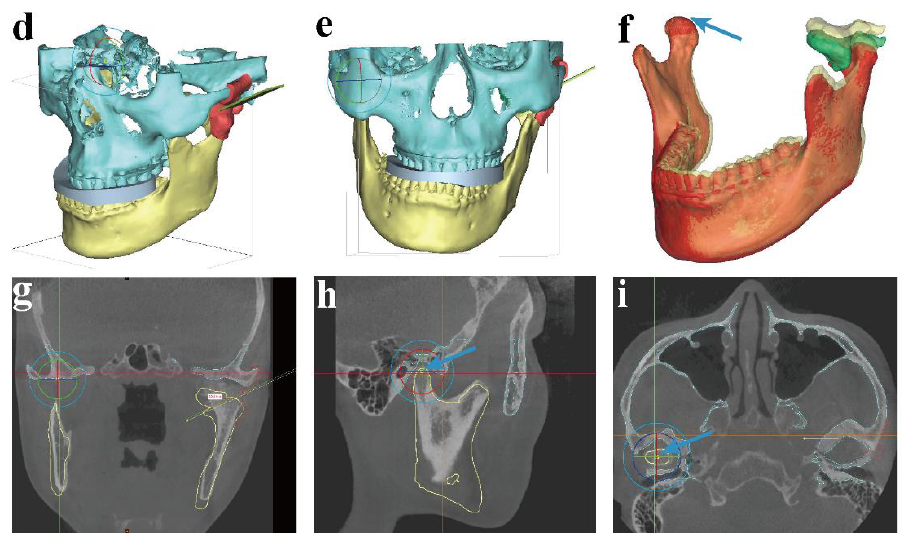
Figure 3. The process of virtual planning and 3D-printed template design. ( a ) The original maxilla, mandible, and condylar OC; ( b , c ) designed DOS, DOT, and adjust direction of the osteotomy plane in the position of the rotated mandible; ( d – f ) the co-point of the non-OC-affected side was set as the rotation center to roll the mandible in a 3D view; ( g – i ) rotation center in 2D view and measurements of osteotomy depth (gray arrow — DOS; red arrow — DOT; green arrow — osteotomy plane; blue arrow — rotation center).